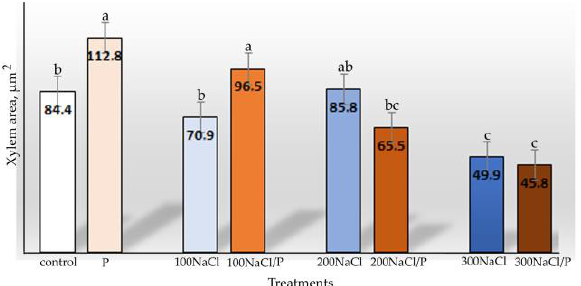
Figure 5. Dependence of xylem area of stem vascular bundle of young Chenopodium quinoa on stress conditions. The values shown are means (±SD). Different letters above the bars indicate a significant difference at p ≤ 0.05.